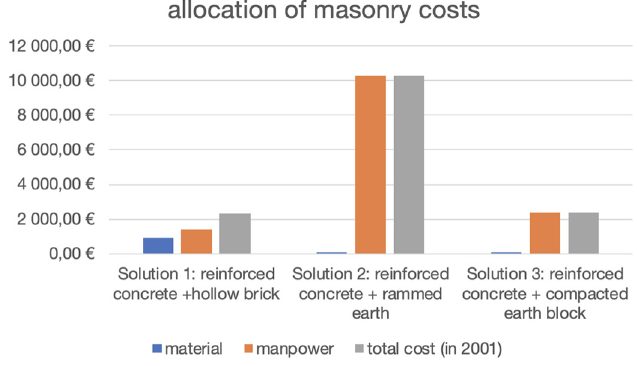
Fig. 8. Allocation of masonry